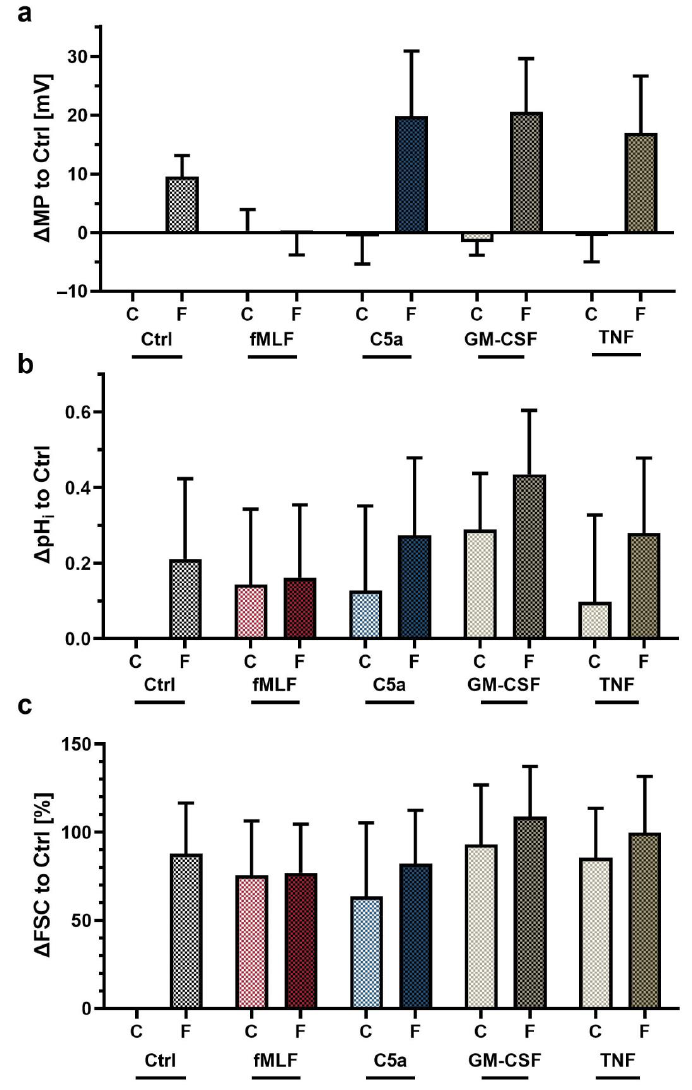
Figure 5. Analysis of the fMLF-induced response in neutrophils after preexposure to various inflam- matory mediators for 60 min. Changes in ( a ) MP, ( b ) pH i , and ( c ) FSC are altered after preincubation with the indicated substances, staining, centrifugation and resuspension with the same substances followed by stimulation with PBS as Ctrl (C) or fMLF (F) for 1 min (MP), 5 min (pHi) and 10 min (pH i ), respectively ( n =